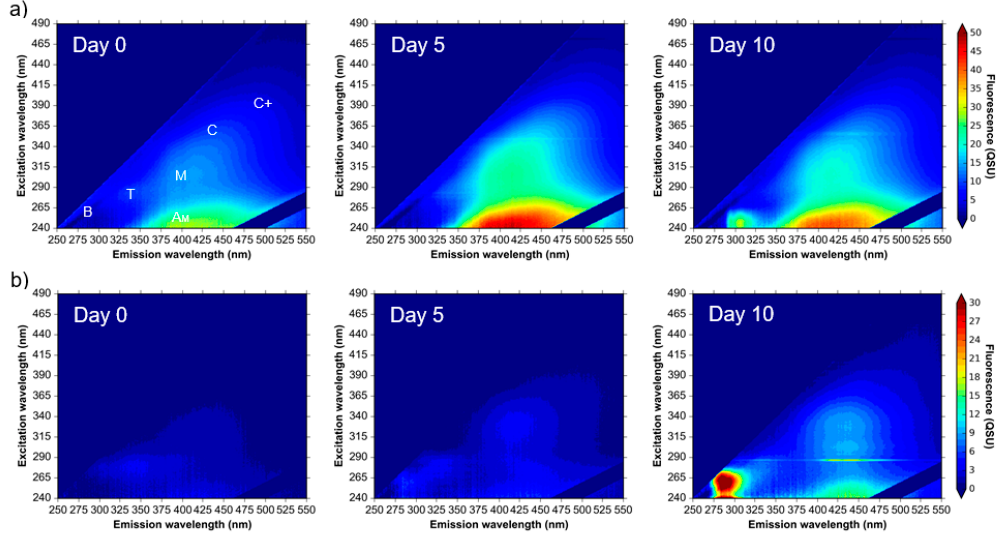
Figure 2. Excitation-emission matrices of ( a ) environmental water samples and ( b ) supplemented synthetic water samples incubated at 20 ◦ C over a 10-day experimental period. Colour bars are in quinine sulphate units, QSU (1 QSU = 1 μ g L − 1 quinine sulphate). Peaks labelled as described in Table 1, derived from Coble et al., (2014) nomenclature [9].